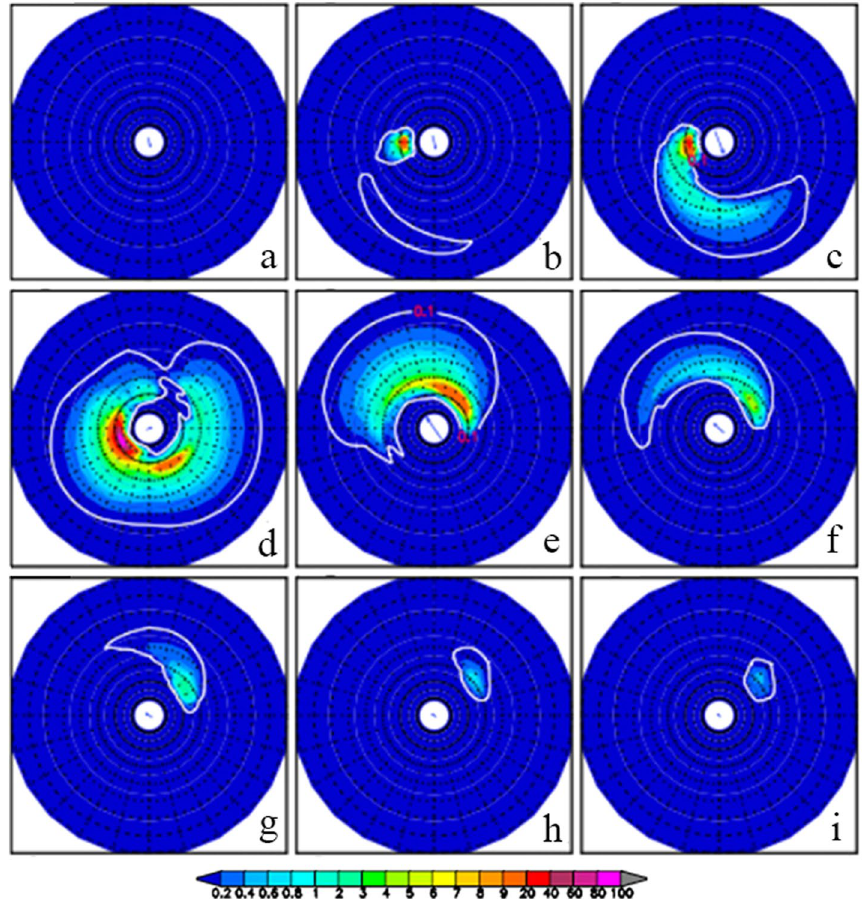
Figure 8. Sensitivity experiment without NE monsoon winds: twelve-hour evolution of directional wave spectra at the reference point (114.0° E, 13.8° N) from 1200UTC December 1 to 1200UTC December 5,